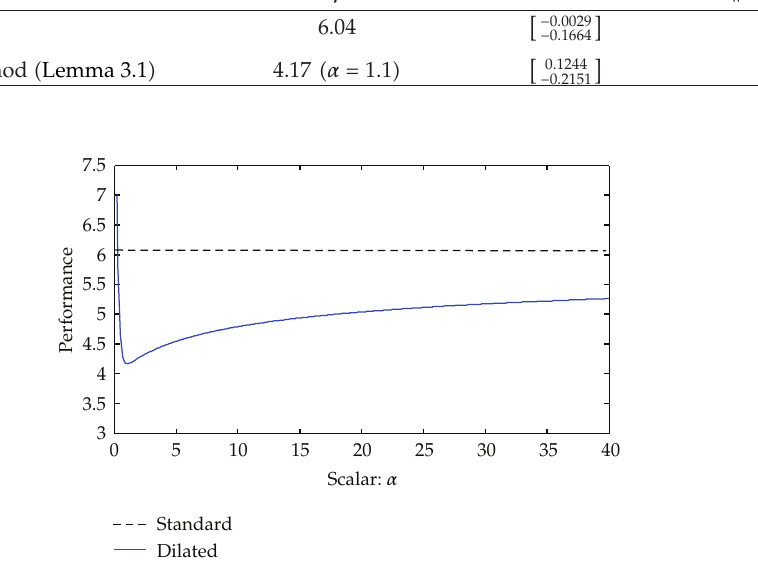
Figure 1: The relation between the performance level γ and the scalar α